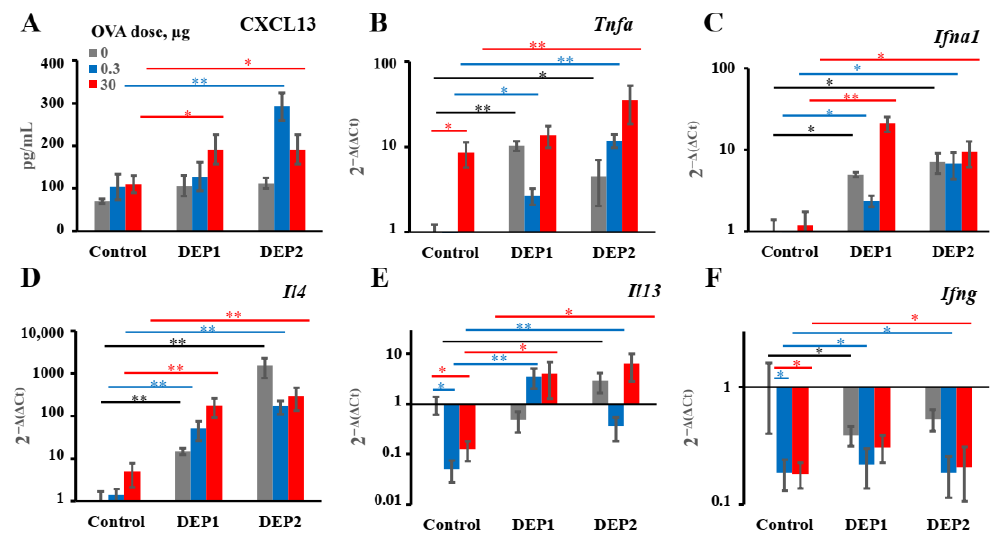
Figure 6. Production of iBALT-inducing chemokines and expression of cytokines in the lung tissue of immunized mice. BALB/c mice were immunized as described in Figure 4 with or without high (150 µg) DEPs doses. Control mice were immunized in the absence of DEPs. The production of CXCL13 ( A ), the expression of the iBALT-promoting cytokines Tnfa ( B ) and Ifna1 ( C ), type-2 immune responses promoting the cytokines Il4 ( D ) and Il13 ( E ), and type-1 immune responses promoting cytokine Ifng ( F ) were measured in the lung tissue. Black bars indicate significant (* — p < 0.05; ** — p < 0.01) differences between the mice immunized without OVA with different DEPs and the respective control without DEPs; green bars indicate significant differences between the mice immunized with a low OVA dose with or without DEPs and the respective control groups; red bars indicate significant differences between mice immunized with a high OVA dose with or without DEPs and respective control groups. The experiment was performed three times. The graphs show the data from three representative experiments (total number of mice included in analysis from all experiments n = 6 per group). The data indicate biological replicates obtained from individual mice.